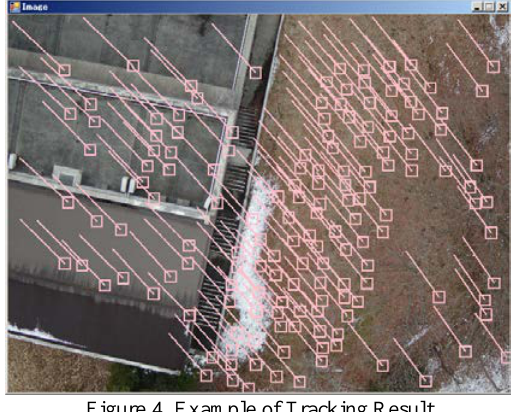
Figure 4. Example of Tracking Result